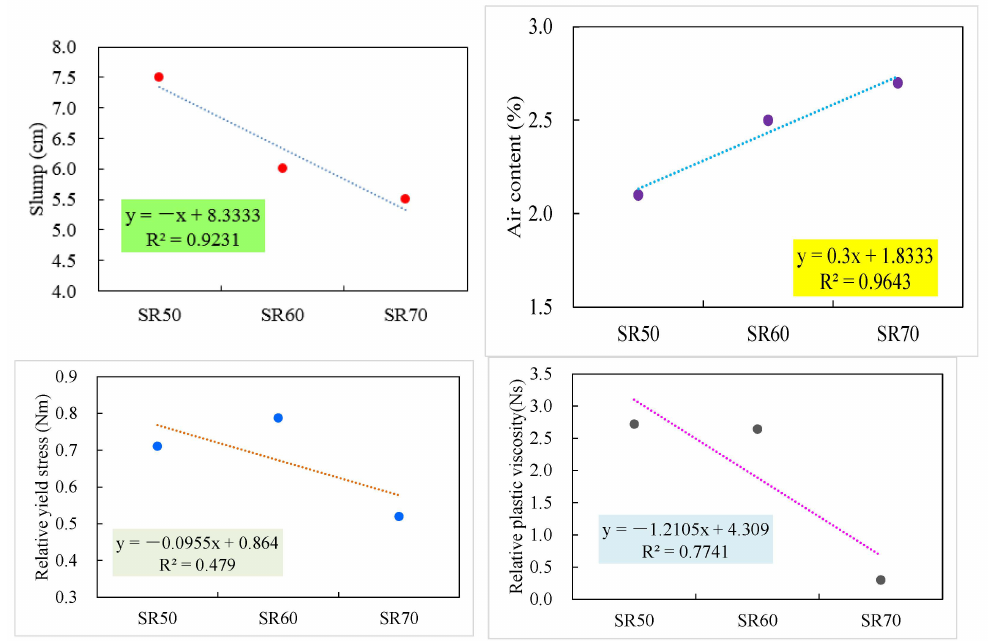
Figure 6. Effect of sand ratio on slump, air content, relative yield stress and